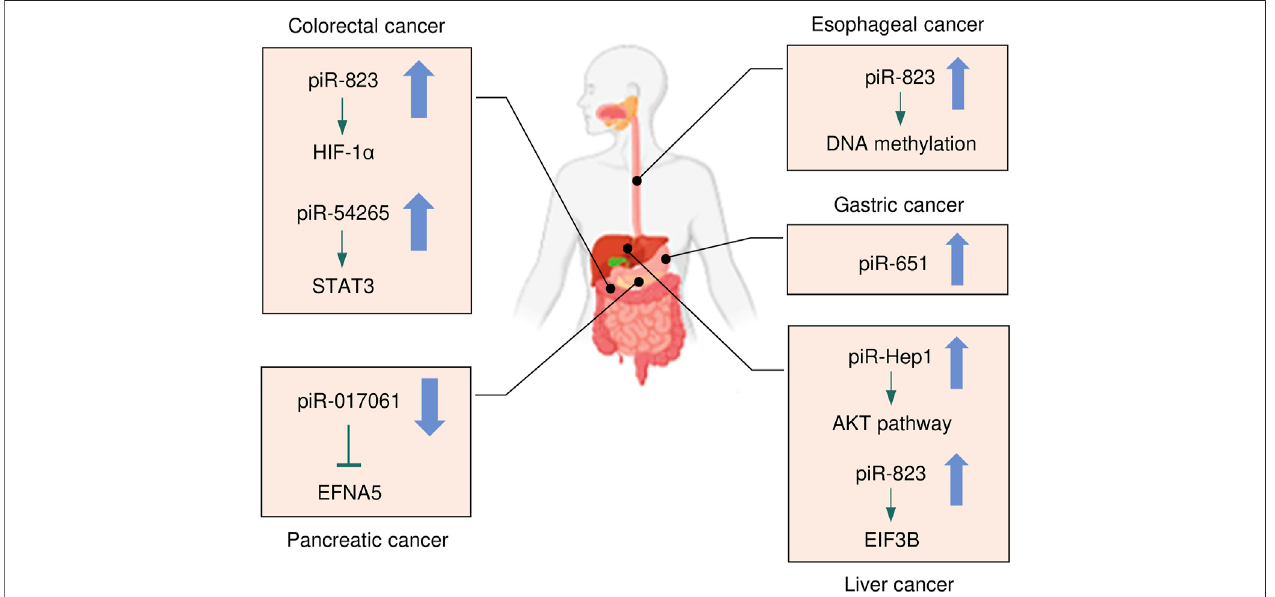
FIGURE 2 | The expression and underlying mechanisms of piRNAs in digestive system cancers. Oncogenic and anti-oncogenic piRNAs and their in fl uence on the downstream pathways in digestive system cancers are shown. The up arrow indicates oncogenic piRNAs that are upregulated in digestive system cancers, while the down arrow suggests tumor-suppressive piRNAs that are downregulated in digestive system cancers.